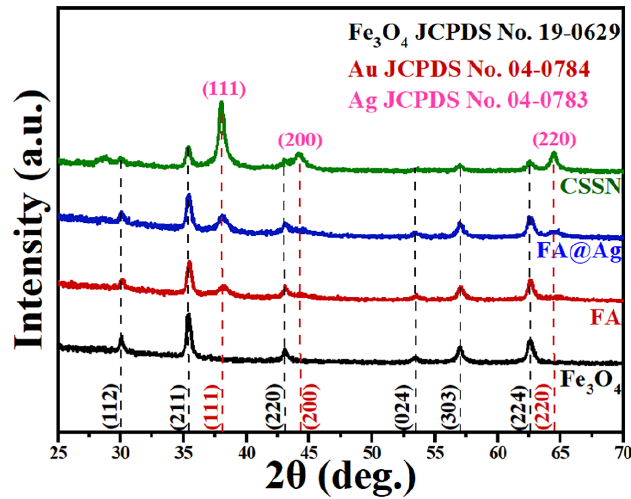
Figure 1. XRD pattern of Fe 3 O 4 hollow spheres, FA, FA@Ag, and CSSN NCs. For researching the magnetic properties of Fe 3 O 4 hollow spheres, FA, FA@Ag, and CSSN NCs, their magnetic hysteresis ( M - H ) loops were tested via vibrating sample mag- netometer (VSM), as displayed in Figure S2. The M-H loops show that Fe 3 O 4 hollow spheres, FA, FA@Ag, and CSSN NCs have superparamagnetic property. The saturation magnetization (Ms) values of Fe 3 O 4 hollow spheres, FA, FA@Ag, and CSSN NCs were 89.1, 74.5, 63.7, and 53.6 emu · g − 1 , respectively. It was found that the Ms value gradually reduces with the incremental introduction of noble metal due to the diamagnetism of noble metal nanocrystals [52]. As depicted in the inset of Figure S2, the CSSN NCs can be collected by an external magnet within 50 s even if their Ms value is the lowest among all the